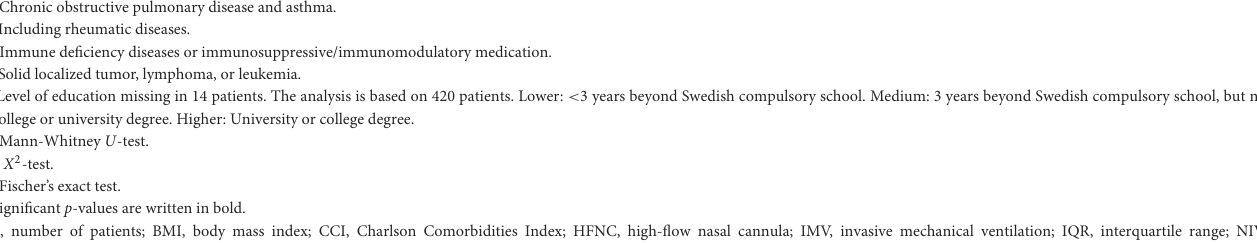
Total ( n = Non-hospitalized 434) patients ( n = 283)